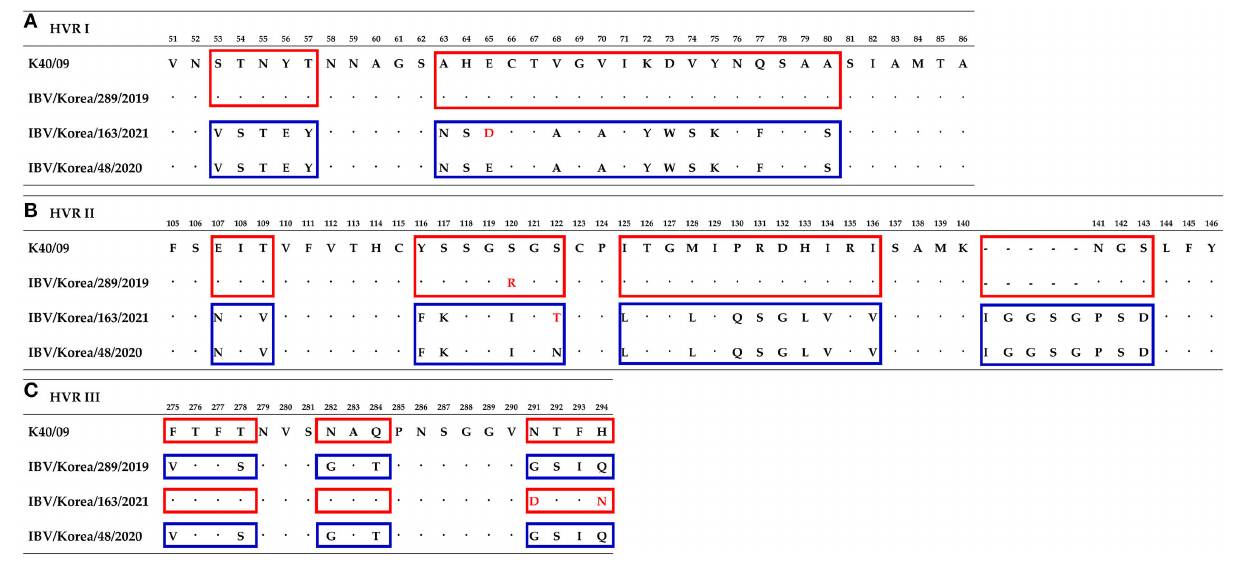
FIGURE3 Comparison of amino acids sequences of hypervariable region at S1 gene between isolates and their parental strains. Numbering is based on isolate K289/19. (A) Hypervariable region I. (B) Hypervariable region II. (C) Hypervariable region III. Similar amino acids sequences with the K40/09 strain are highlighted in red boxes. Blue boxes indicate amino acids sequences similar to the IBV/Korea/48/2020 strain. Substitutions of amino acids are highlighted with red font.